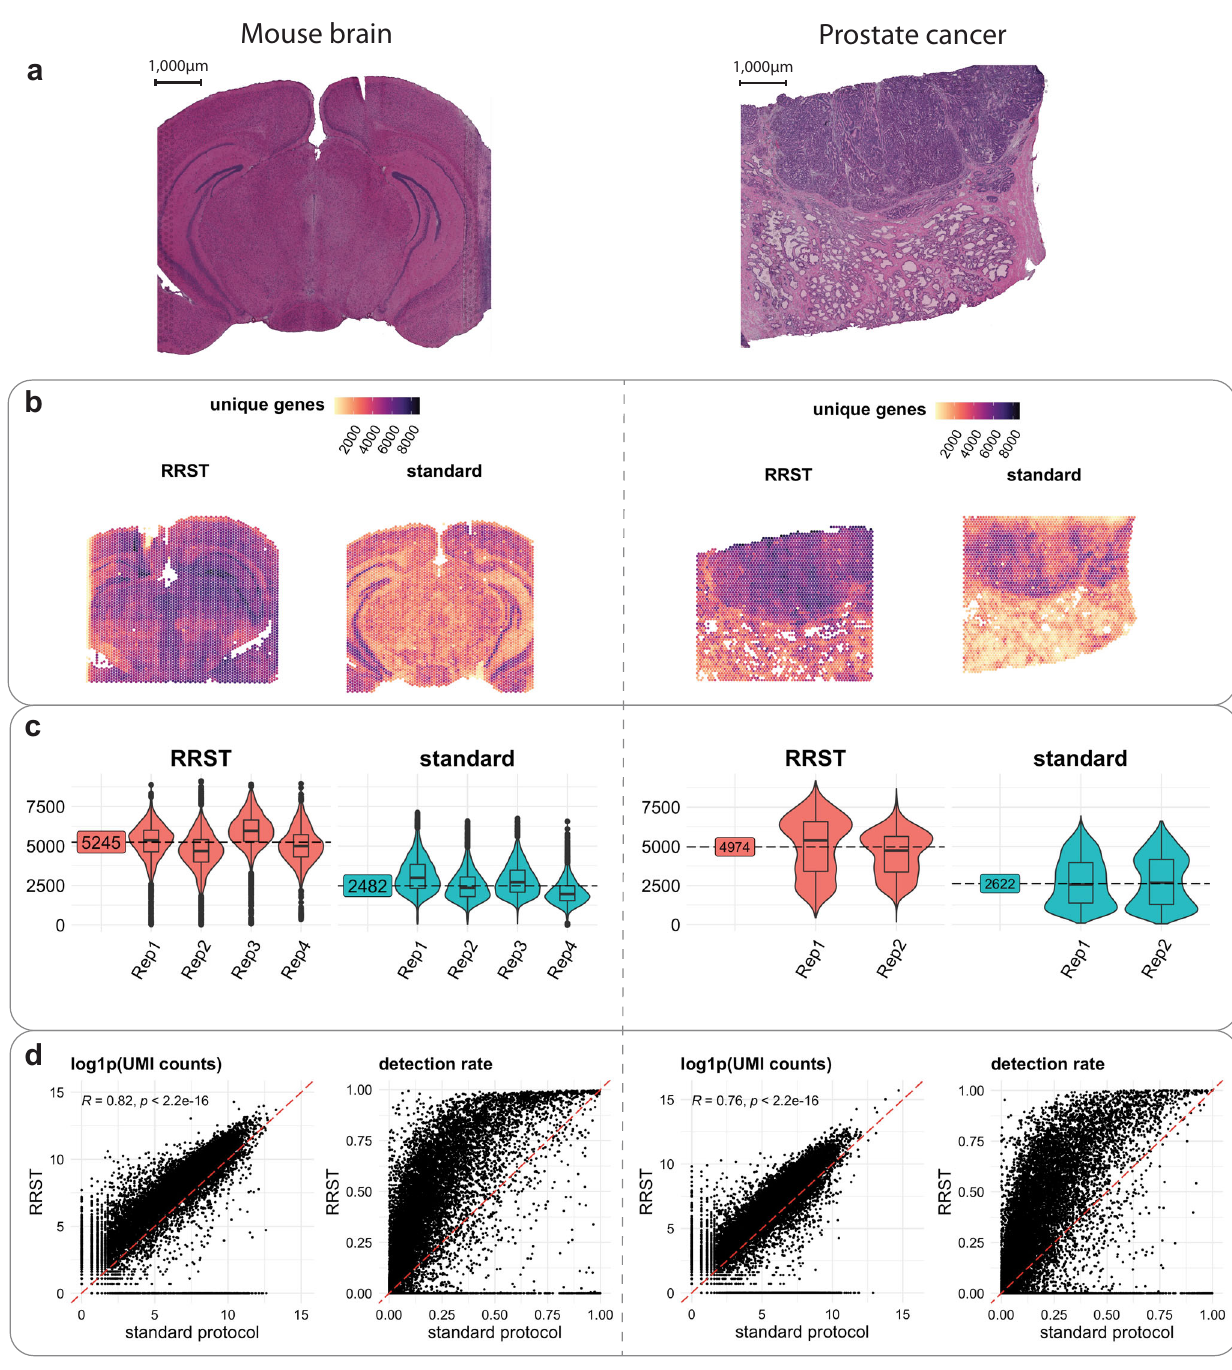
Fig. 1 | Comparison of RRST and Visium on mouse brain and prostate tumor samples. a H&E images of a representative tissue section from mouse brain (left) and prostate cancer (right). The entire dataset consisted of 8 consecutive mouse brain tissue sections and 4 consecutive prostate cancer tissue sections. Half of the tissue sections were processed with RRST and the remaining half with standard Visiumprotocol. b Spatialdistributionofuniquegenesintworepresentativetissue sections for each tissue type, one processed with the RRST protocol and one processed with the standard Visium protocol. c Distributions of unique genes per spot visualized as violin/box plots colored by experimental protocol for mouse brainandprostatecancerdata.Boxplotsarepresentedasmedianvalueswherethe lower and upper bounds are the 25th and 75th percentiles. The upper and lower limits of the boxplots are de fi ned by the closest value no further than 1.5*IQR